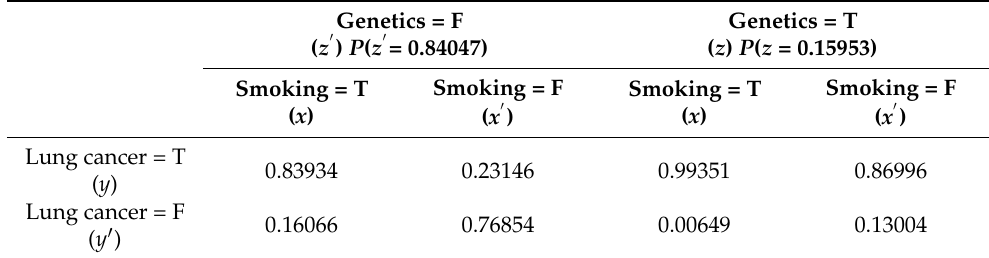
Table 1. Frequency data comparing lung cancer among smoking ( x ) and no smoking ( x (cid:48) ) in